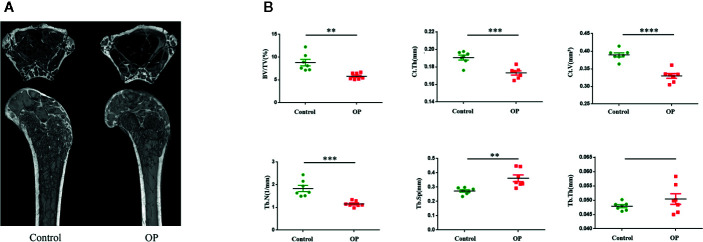

(A) Images of representative 3-dimensional Micro CT reconstructions of examined femurs from each group. (B) Evaluation of femoral bone of control and OP mice by Micro CT after 70 days. Comparision of BV/TV, Ct.Th,Ct.V, Tb.N,Tb.Sp, Tb.Th in the two groups. (n = 7 mice per group in all panels. Data are expressed as mean ± SEM. *P < 0.05, **P < 0.01, ***P < 0.001, and ****P < 0.0001).